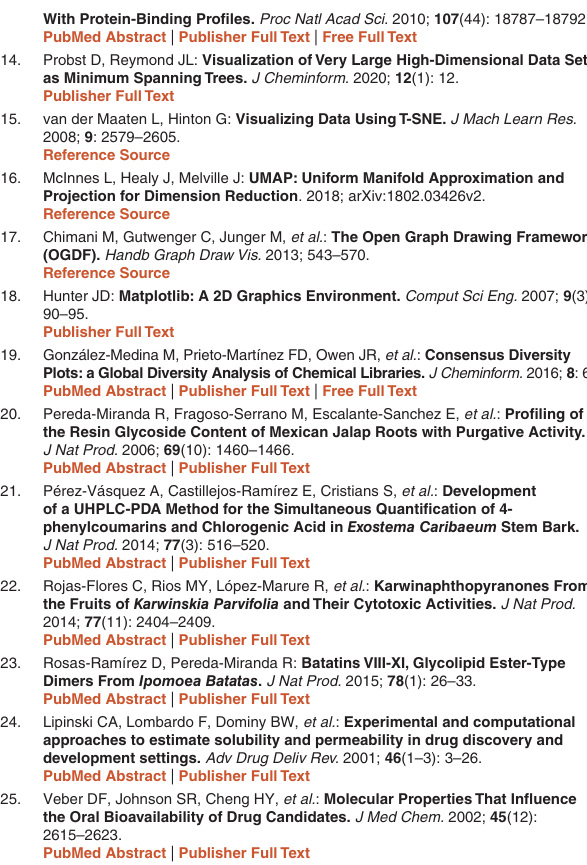
Figshare: BIOFACQUIM_V2. http://doi.org/10.6084/m9.figshare. 11312702